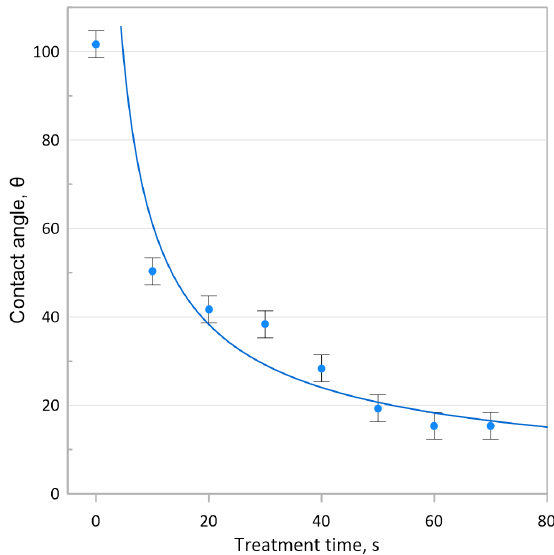
Figure 1. Dependence of the contact angle variation of a distilled water drop on the surface of the control ZrB 2 –SiC sample versus cold plasma treatment time.